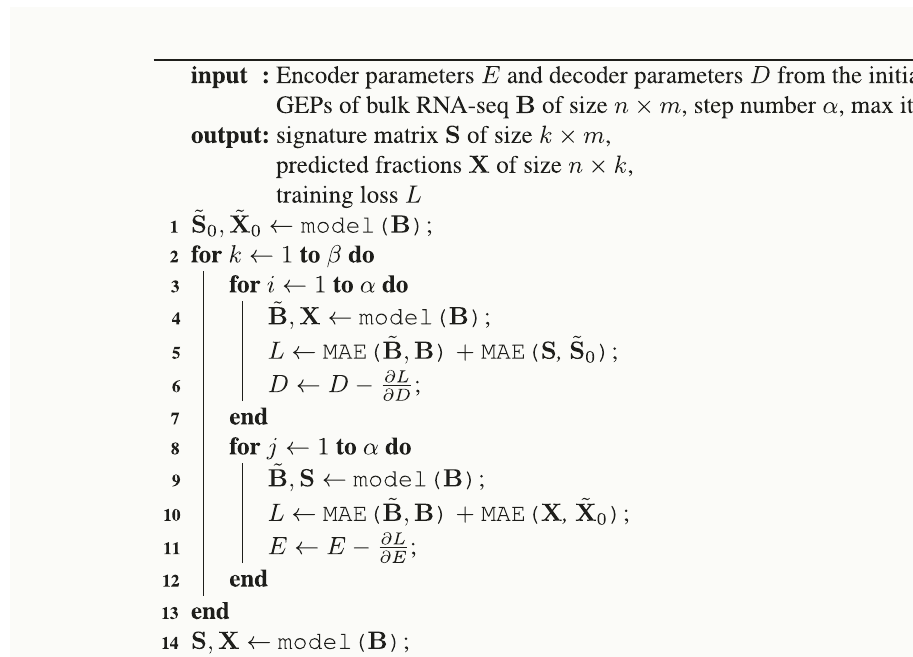
Table 1 | Adaptive training